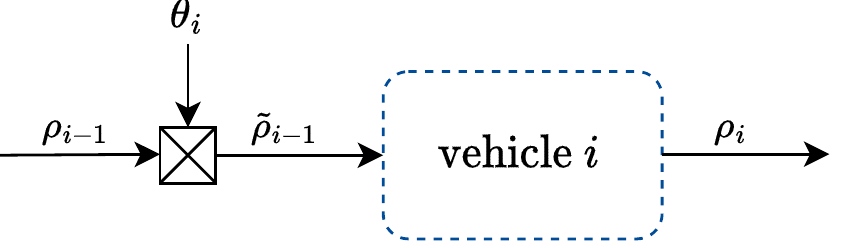
Figure 3. Lossy communication channel model for the i -th vehicle. The random data losses are described by the Bernoulli variable θ i